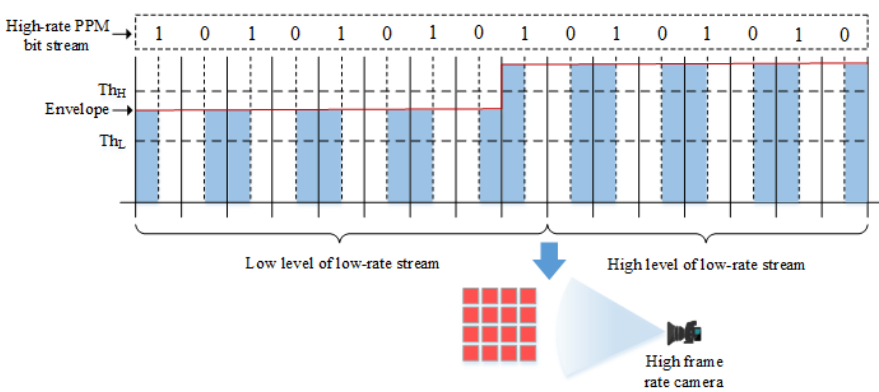
Figure 4. Proposed BPPM scheme for optical vehicular communication using a single